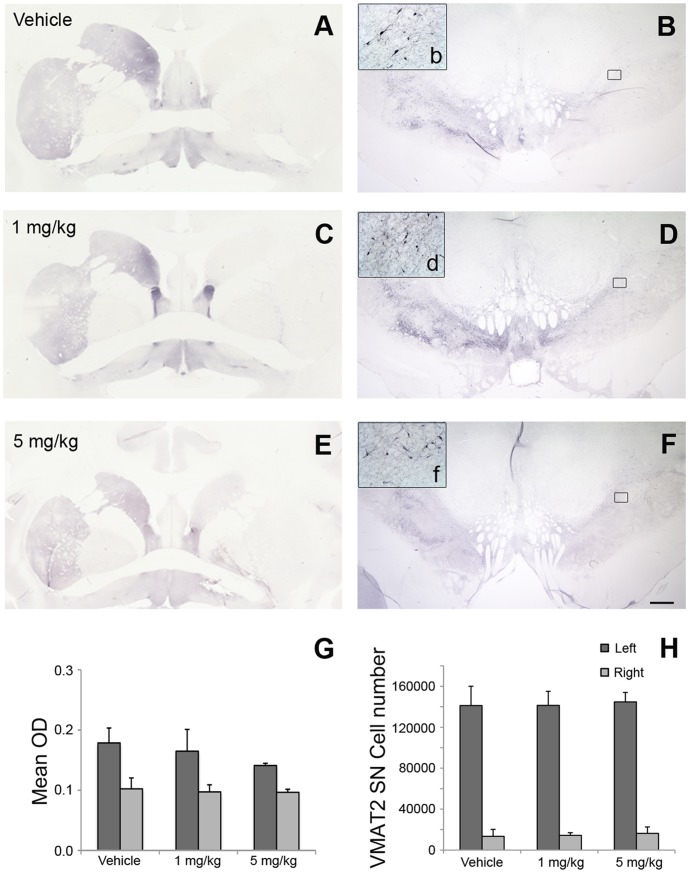
VMAT2 expression is not affected by HIRmAb-GDNF treatment.(A to F) Coronal images of the striatum at the level of the anterior commissure (A, C, and E) and of the substantia nigra at the level of the red nucleus (B, D, and F) stained with the dopaminergic marker VMAT2 of monkeys treated with vehicle (A and B), 1 mg/kg (C and D), or 5 mg/kg (E and F) HIRmAb-GDNF. Scale bar: 2.5 mm (A, C, and E); 1 mm (B, D, and F); 110 µm (insets b, d, and f). (G) VMAT2 optical density (OD) in the caudate and putamen nucleus. (H) Stereological cell counts of VMAT2-positive neuron cells in the substantia nigra.